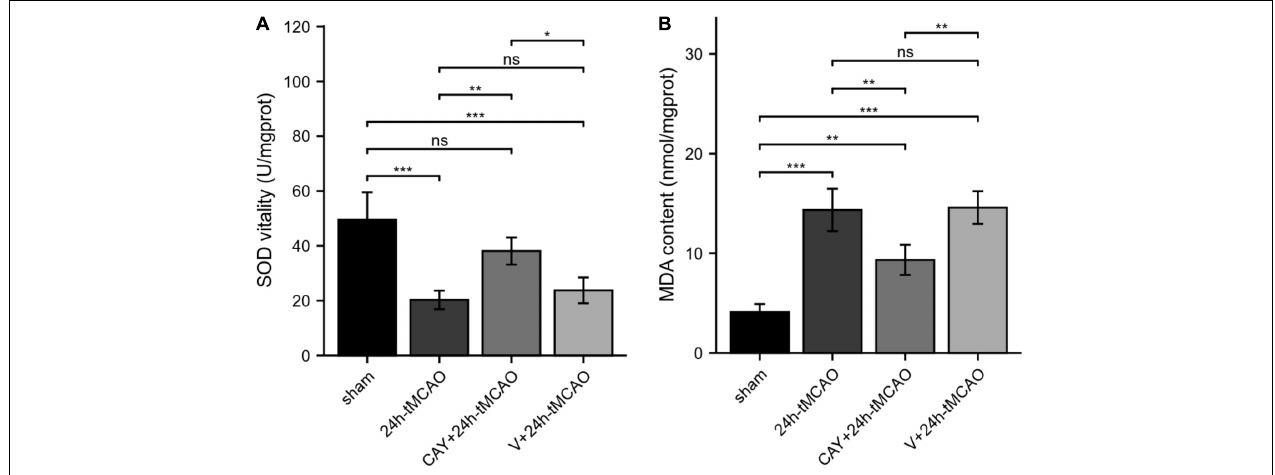
FIGURE 6 | SOD vitality and MDA content in mice subjected to tMCAO. (A) SOD vitality was measured ( n = 4). (B) MDA content was measured ( n = 4). Data are presented as the mean ± SEM. P -values were determined by ANOVA followed by the Tukey post hoc test, * P < 0.05; ** P < 0.01; *** P < 0.001; and ns, not significant.